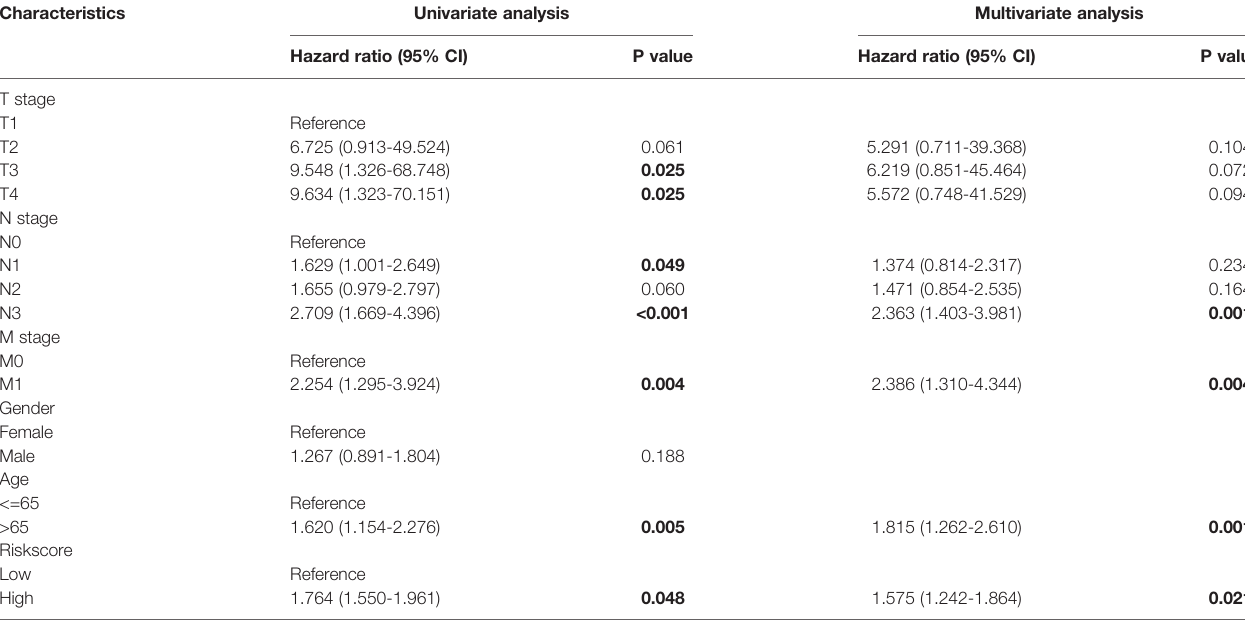
TABLE 3 | Independent prognostic value of the prognostic risk score model. Bold values indicate signi fi cant P-values (<0.05)